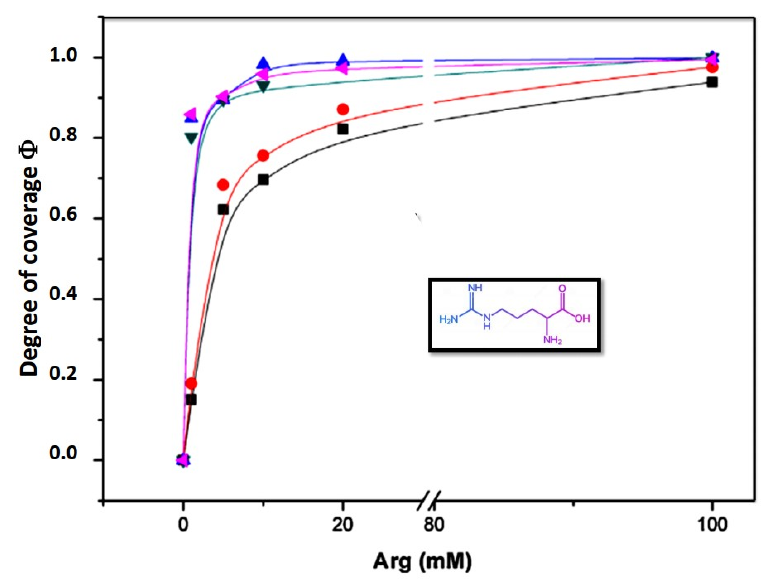
Figure 4. Adsorption isotherms of arginine (Arg) in lipid vesicles of DMPC, dmPE, mmPE, DMPE. Adapted from [27].